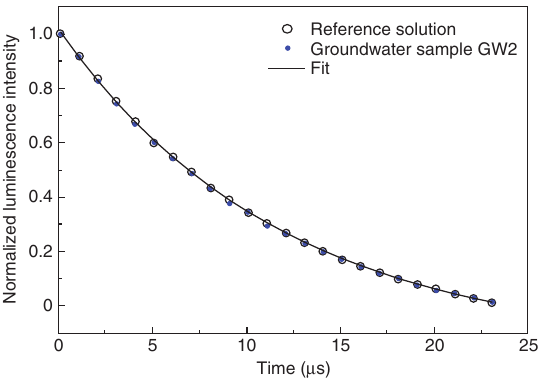
Figure 6 Solid line represents the calibration curve obtained by plotting the luminescence intensity of the reference solutions at 493.1 nm as a function of the uranium concentration. Squares represent the determined uranium concentrations in the groundwater samples, and the values are listed in Table 2 (column